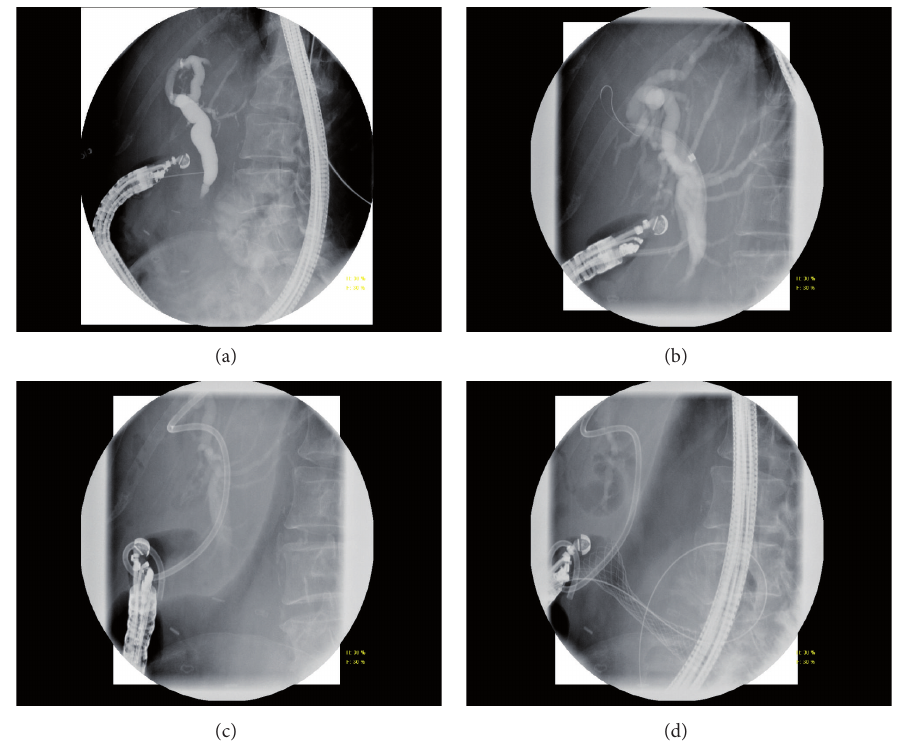
Figure 1: Transluminal stenting in a patient with metastatic breast cancer with extrahepatic biliary and duodenal obstruction. (a) Initial Cholangiogram using 22-gauge needle via transduodenal approach. (b) Choledochoduodenostomy tract dilation with 7–10 Fr dilating catheter. (c) Placement of a 10Fr × 6cm double-pigtail plastic stent. (d) Placement of a 22 × 60mm uncovered enteral